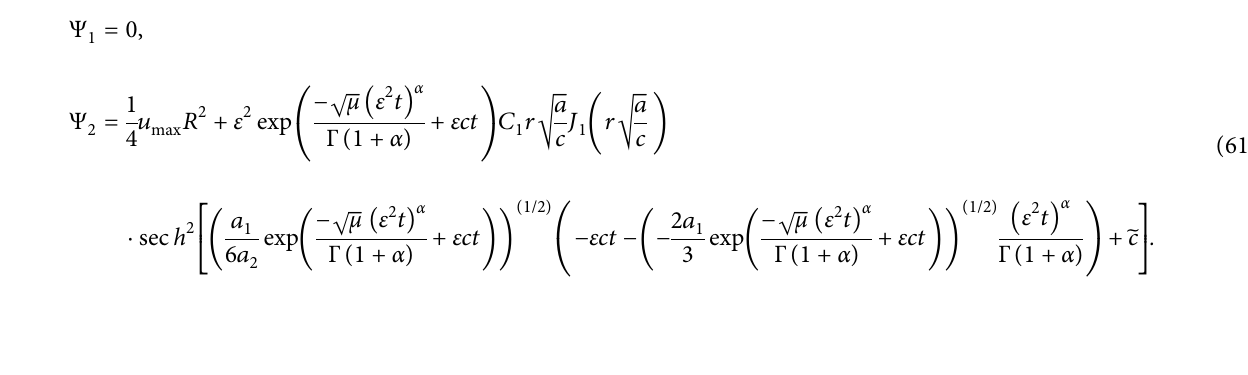
Figure 3: The evolution of solitary waves with different numbers of fractional order α ( T � 1 , a